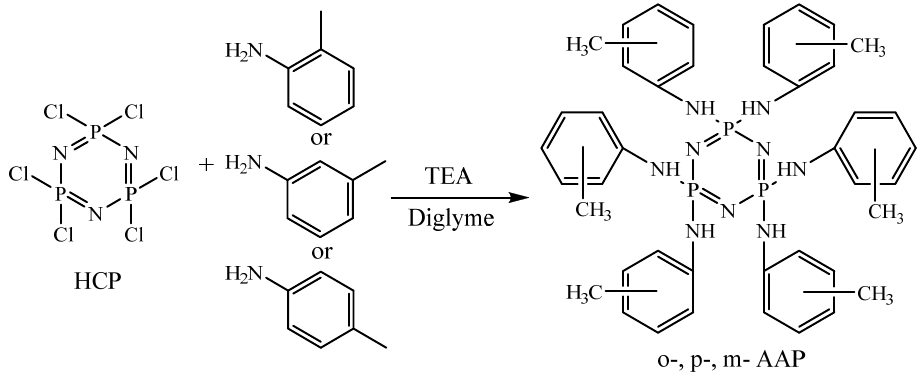
Figure 1. Scheme of obtaining